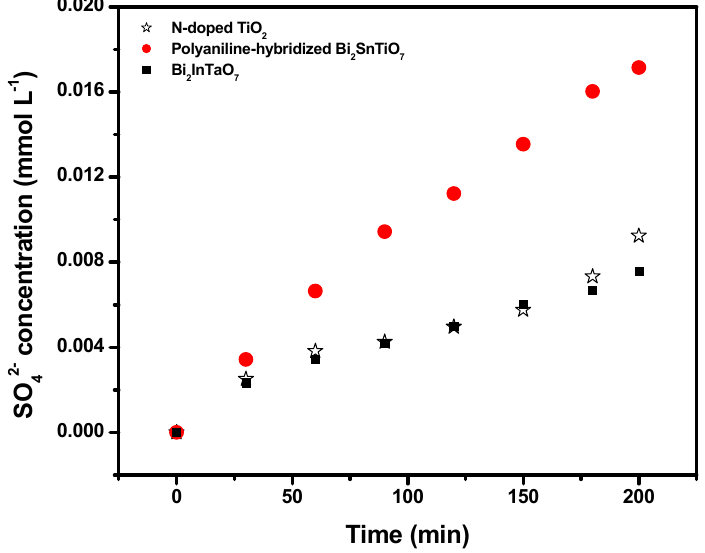
Figure 7. The concentration variation of SO 42 − during photocatalytic degradation of methylene blue with the polyaniline-hybridized Bi catalyst under visible light